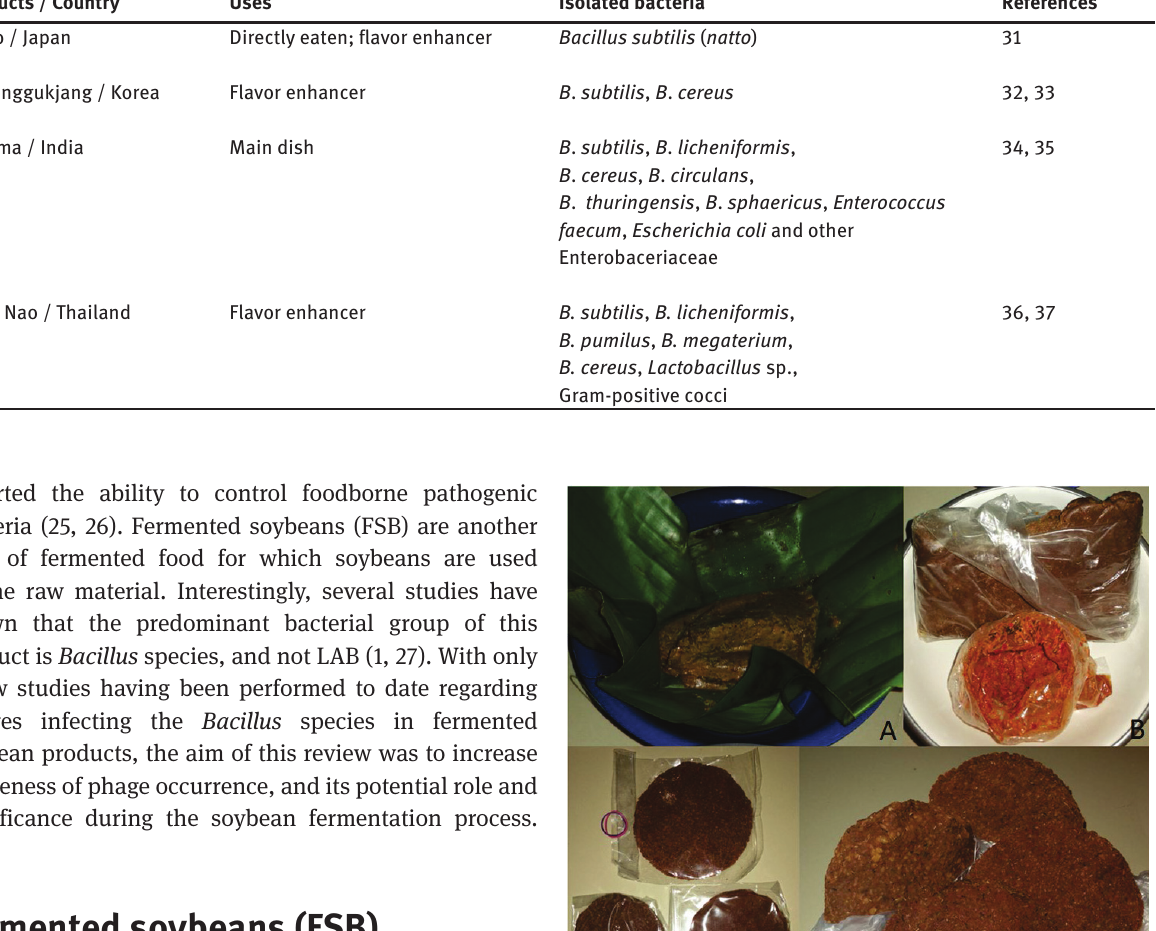
Table 2: Fermented soybean products and their characteristics. Products / Country Uses Isolated